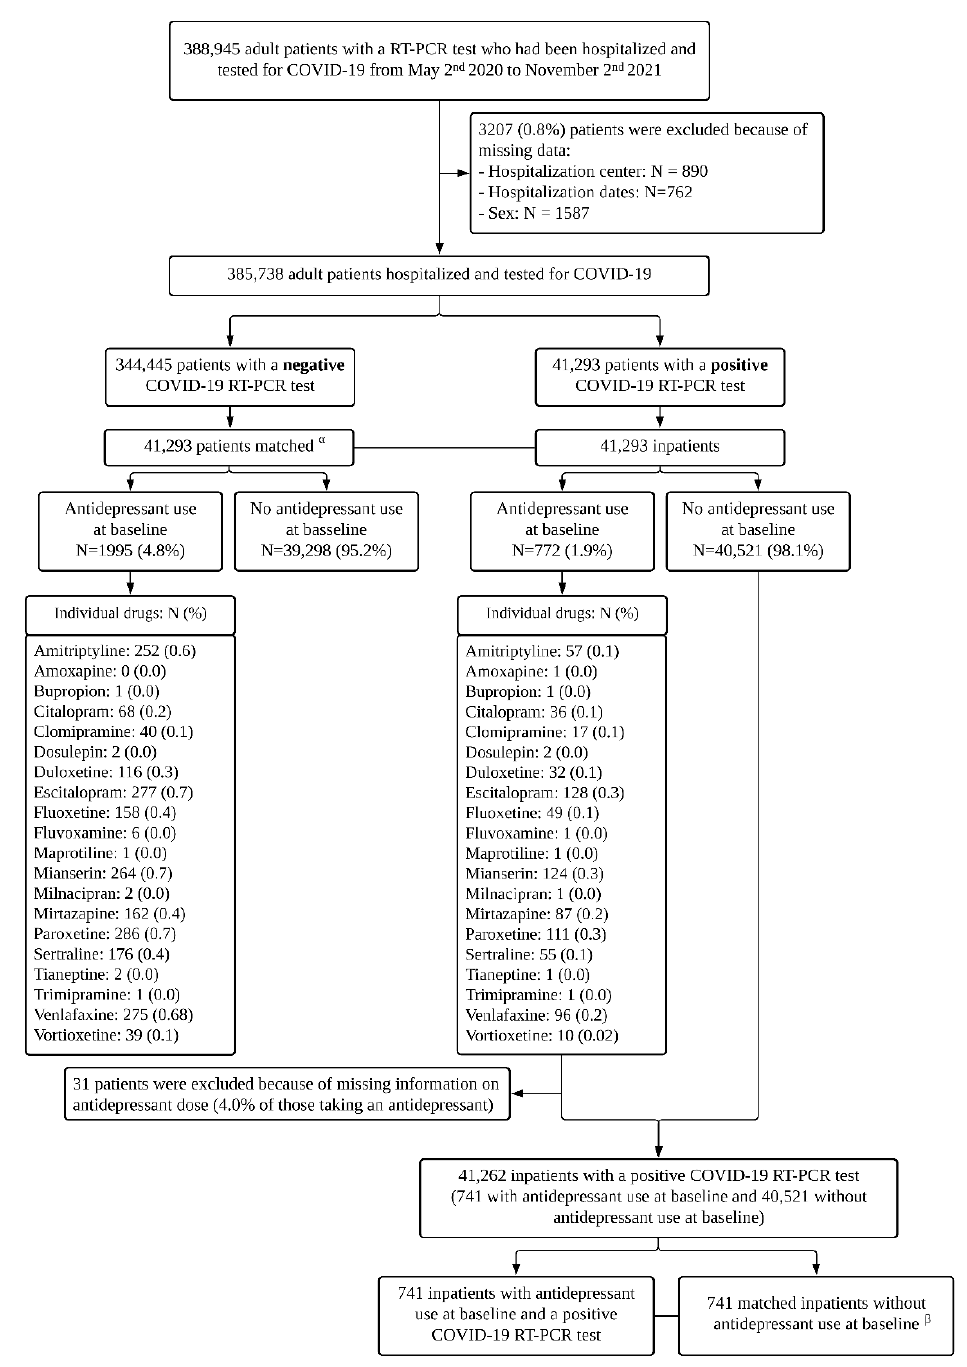
Figure 1. Study cohort. α Matched for age, sex, hospital, period of hospitalization, and number of medical conditions. β Matched for age, sex, hospital, period of hospitalization, number of medical conditions, any current diagnosis of psychiatric disorders, use of other psychotropic medications (benzodiazepines or Z-drugs, antipsychotic medications, mood stabilizers) or any medication prescribed according to compassionate use or as part of a clinical trial, and clinical and biological markers of COVID-19 severity.